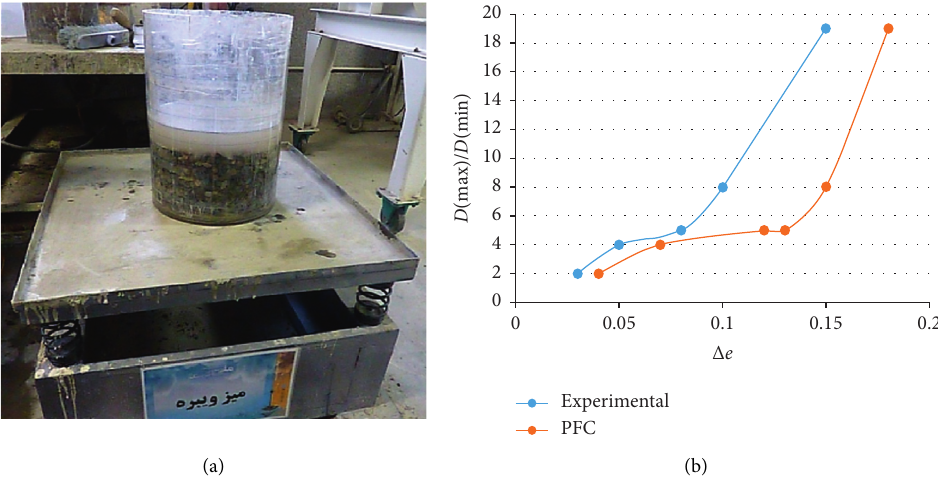
Figure 4: (a) Comparison of laboratory results and numerical modeling of Shabanpour and (b) Shabanpour experiment with vibrating table.